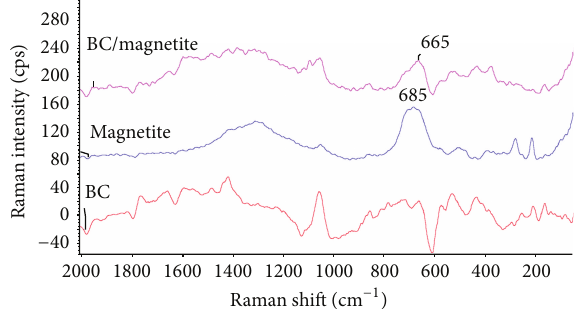
Figure 1: Raman spectra of pure BC, magnetite, and BC/magnetite 5% membranes.